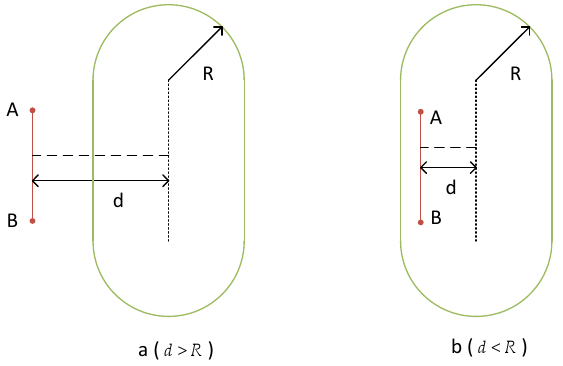
Figure 9. Diagram of the Intersection Detection of a Line Segment and a Capsule. (5) Intersection of a line segment and a triangular patch